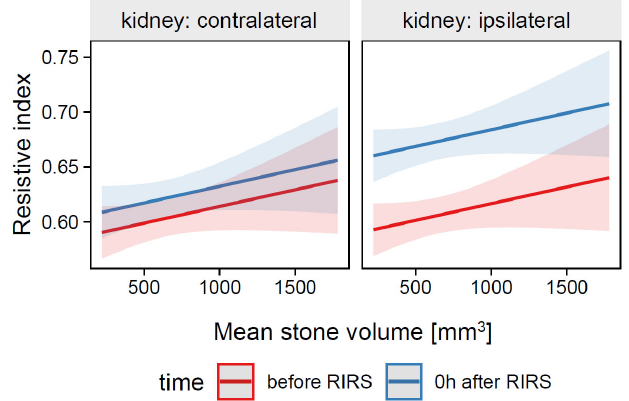
Figure 2. Predicted values (marginal e ff ects) of resistive index by the Mod1 regression model for mean stone volume, time, and kidney side terms.